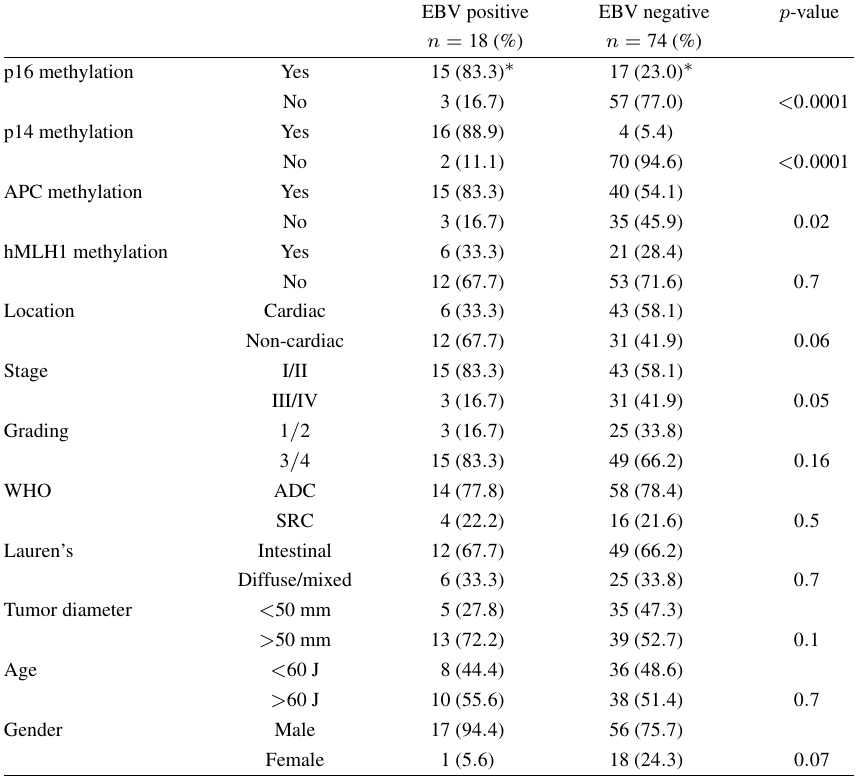
Results in EBV-positive and negative gastric and cardiac